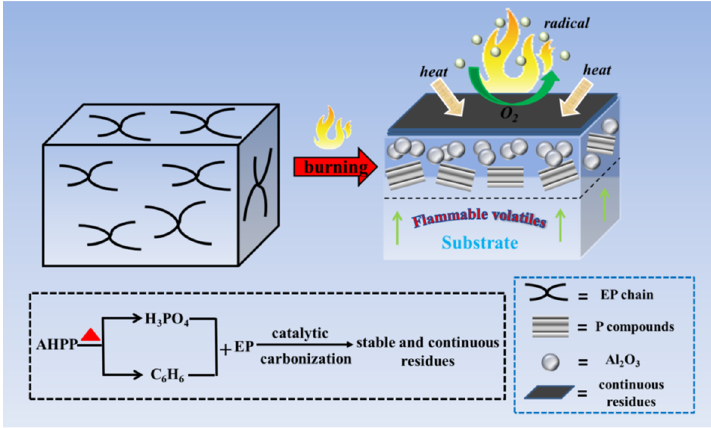
Figure 8. Illustration of the mechanism for the enhanced flame retardance and smoke toxicity suppression of EP/DOPO-AHPP composite.